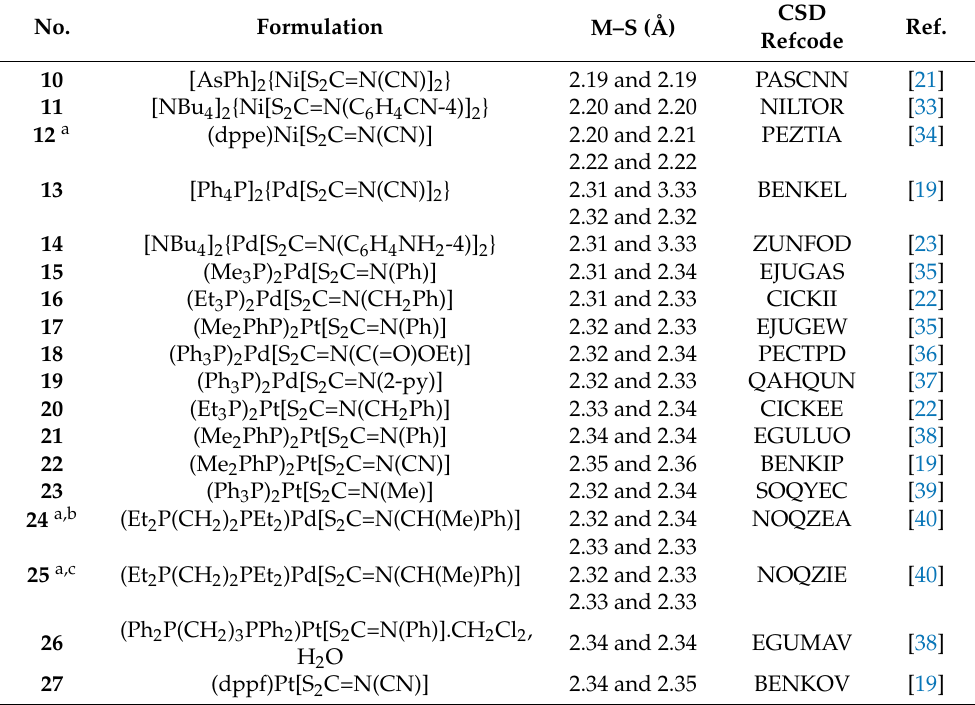
Table 1. Structural data for the nickel-triad elements complexed by dithiocarbimate ligands. No.